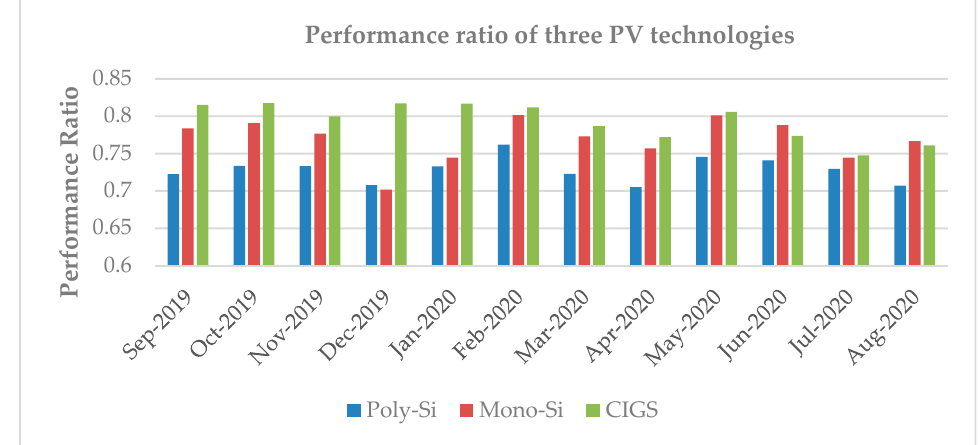
Figure 5. Performance ratio comparison for three PV technologies.